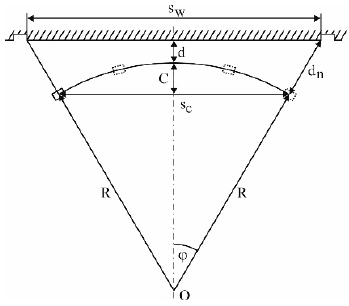
Figure 6. The curve linear run and measurement data, R —radius of curvature, d , d n distance between vehicle and reference surface, s w , s C measured path, 0 middle of the arc, half arc angle ϕ .